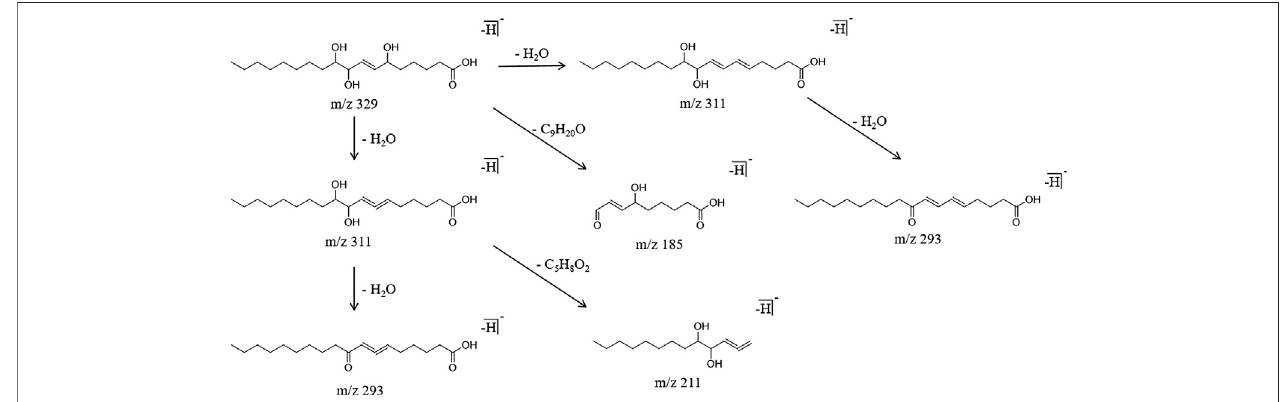
FIGURE 7 | Cracking pathway of organic acids.